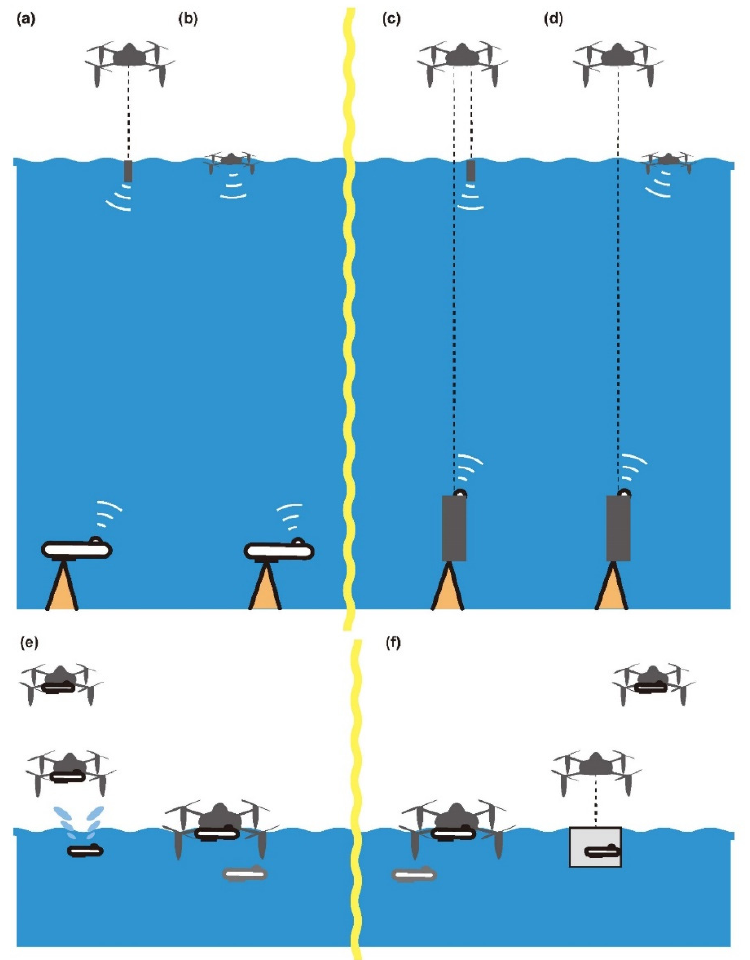
Figure 1. Conceptual schematics for underwater communication using UAVs and AUVs. ( a ) Hanging an acoustic base station from a UAV hovering above the sea surface during an AUV survey. ( b ) Acoustic base station installed on a sea-surface UAV during an AUV survey. ( c ) Hanging both an underwater sonar and acoustic base station from a hovering UAV. ( d ) Suspending an underwater sonar from a hovering UAV with an acoustic base station installed on a sea-surface UAV. ( e ) Transporting a UAV with an AUV. ( f ) Retrieving an AUV with a UAV.